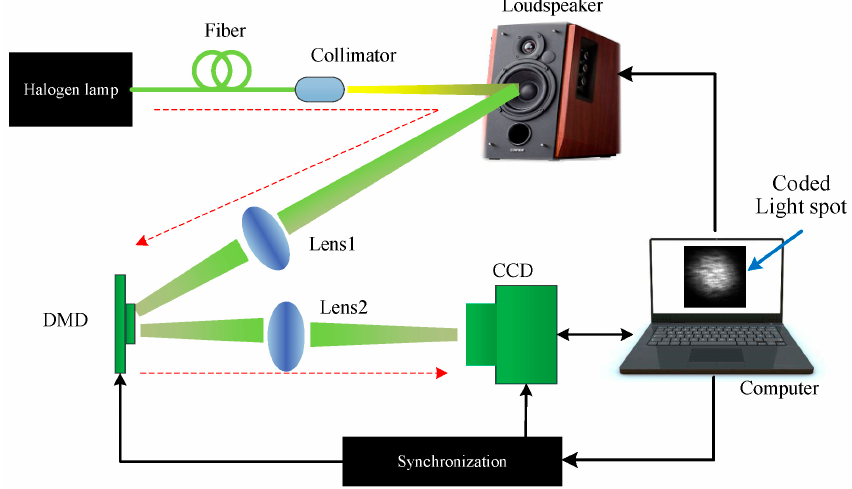
Figure 8. The experimental setup. The red dashed arrow line indicates the light path.